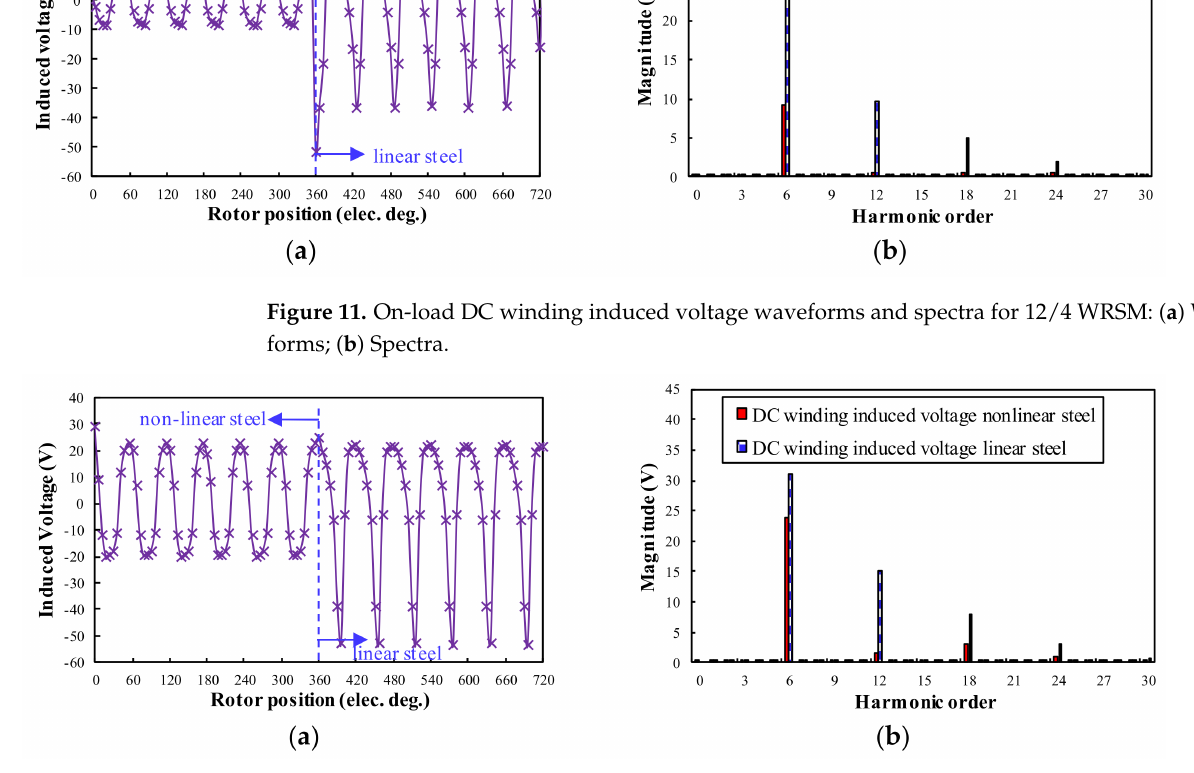
Figure 12. On-load DC winding induced voltage waveforms and spectra for 24/4 WRSM: ( a ) Wave- forms; ( b ) Spectra.